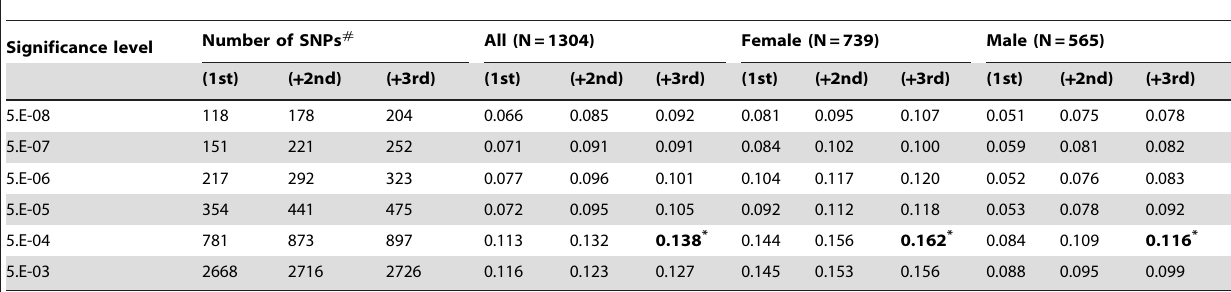
Table 2. Fraction of height variance